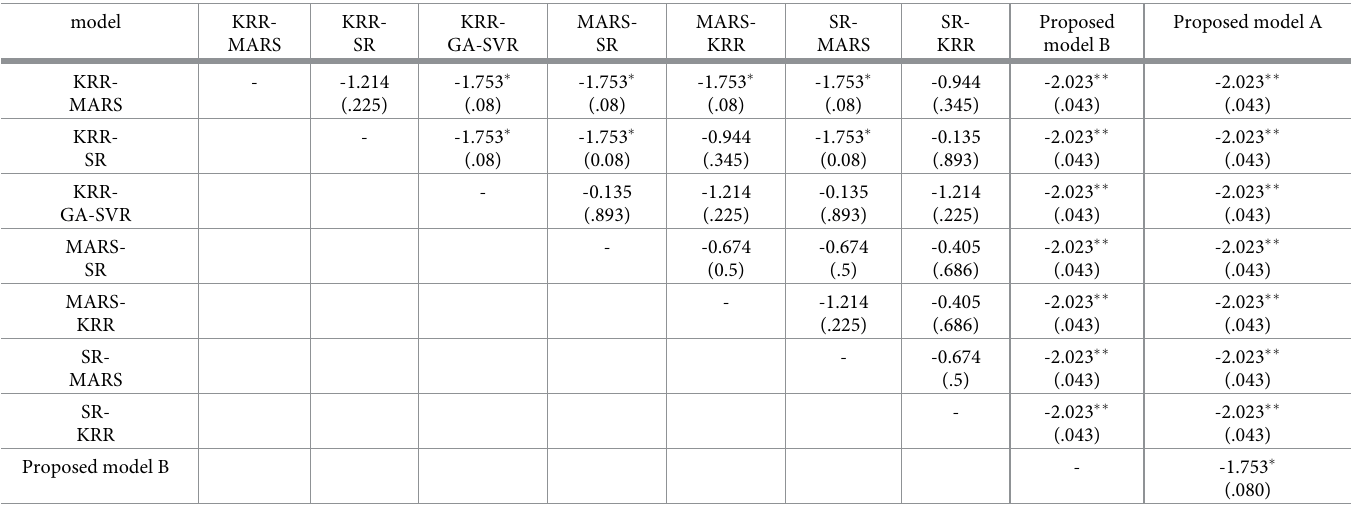
clude that the proposed model B (SR-GA-SVR) has better performance than the listing models, especially in larger price fluctuation. i . e ., we can confirm that the features selected by SR can effectively enhance the accuracy in the short testing period. Table 14. Wilcoxon sign test for different models comparison in long